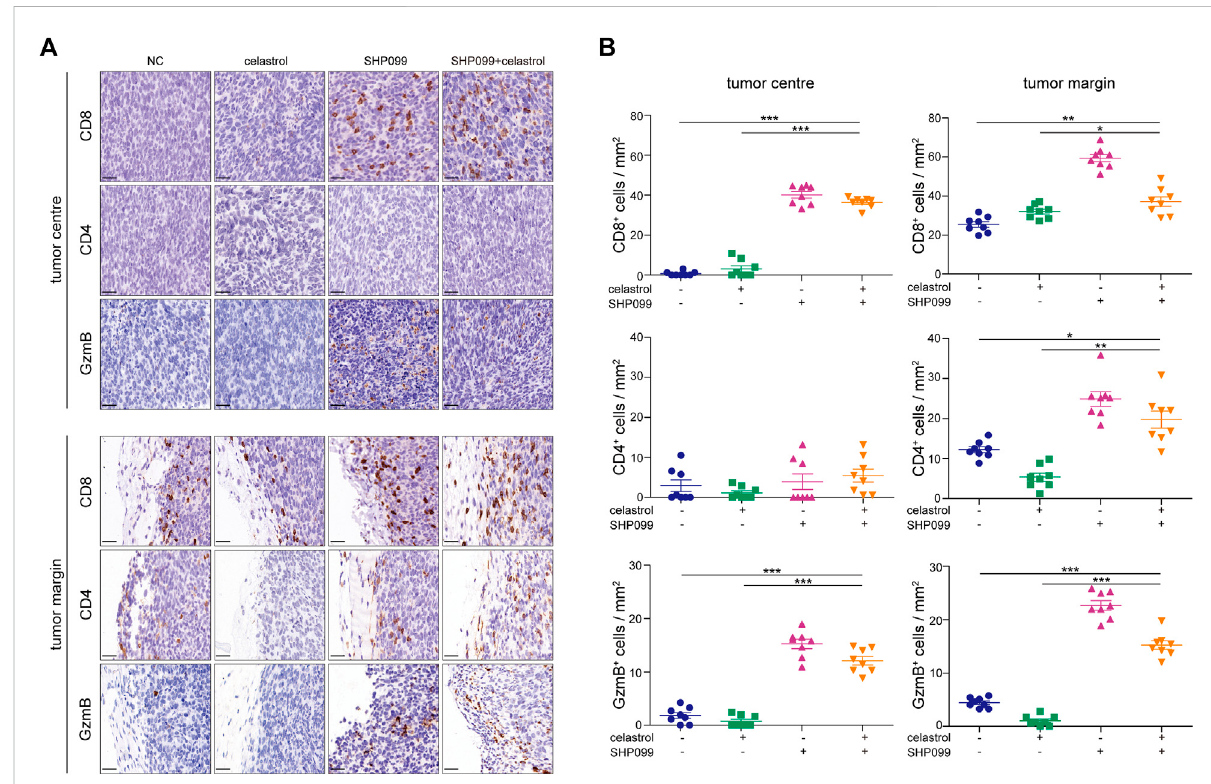
FIGURE 6 SHP099 enhances the antitumor role of celastrol by promoting T-cell in fi ltration. (A) In fi ltration of CD8 + , CD4 + , and GzmB + cells in CRC xenografts treated with SHP099 alone, celastrol alone, or their combination using IHC examination. (B) Quanti fi cation of CD8 + , CD4 + , and GzmB + cells in tumors treated with SHP099 alone, celastrol alone, or their combination. * p < 0.05; ** p < 0.01; *** p < 0.001. Scale bar: 20 μ